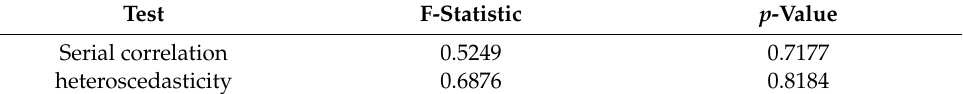
Table 8. Diagnostic Test Results.